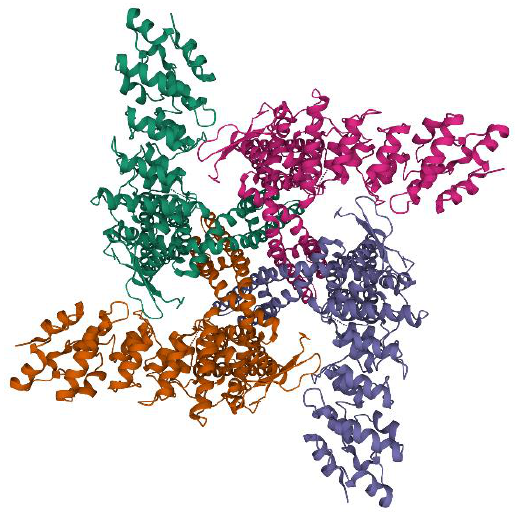
Figure 3. Three-dimensional structure of TRPV1. The image shows a caption of the protein structure obtained by Liao et coll. (2013) using single-particle electron cryo-microscopy [26]. Obtained from https://www.rcsb.org/structure/3J5P (accessed on 20 April 2021), PDB ID 3J5P; [29,30].